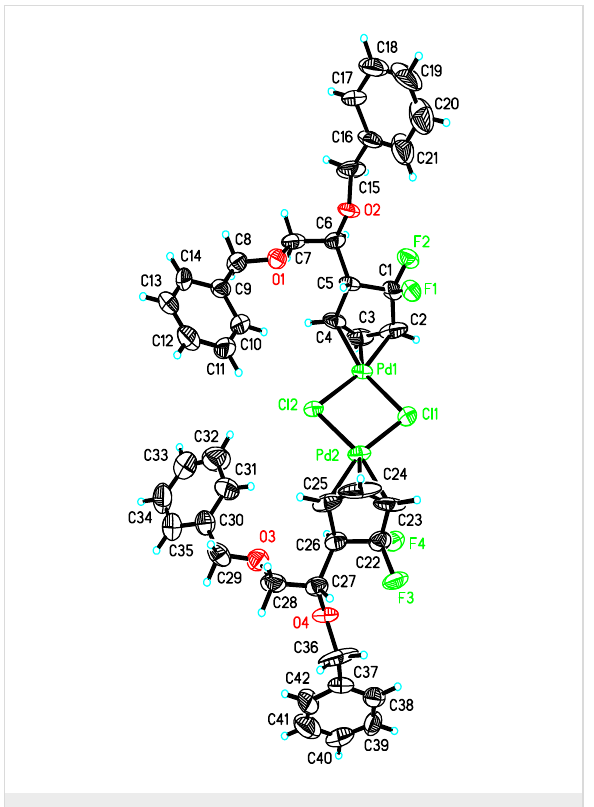
Figure 1: X-ray structure of trans - trans dimer 8 .